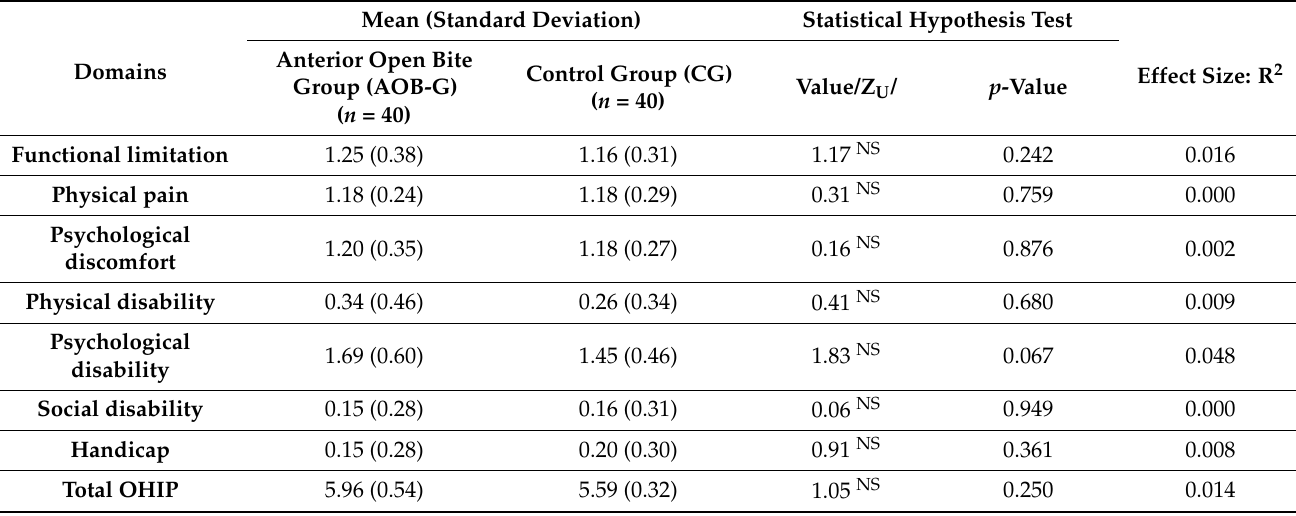
Table 2. Differences in the domains of the OHIP-14 questionnaire by group ( n =